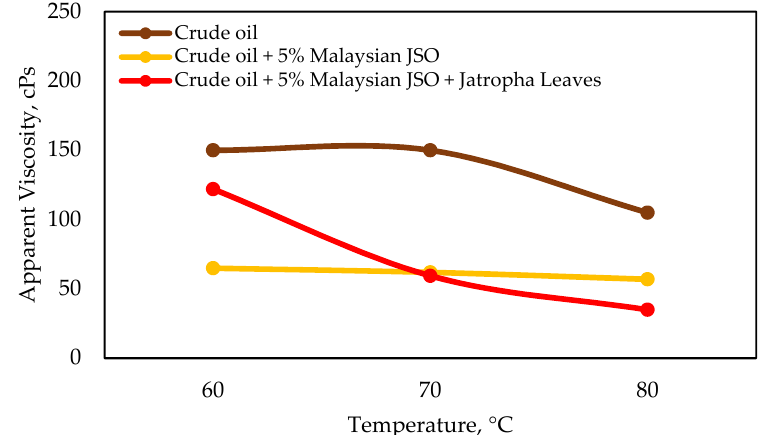
Figure 13. Rheological test of Panera waxy crude oil blend with the mixture of powdered Jatropha leaves and 5% Malaysian Jatropha seed oil.